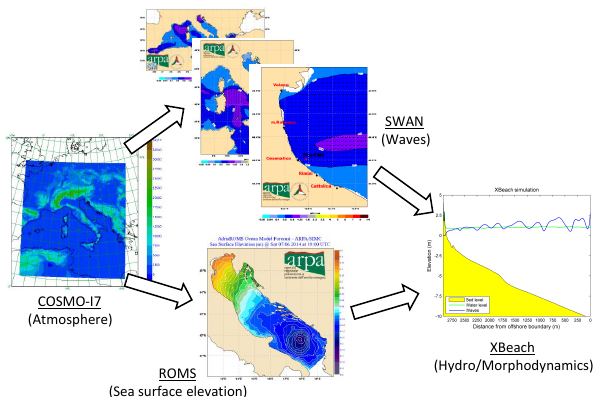
Figure 2. The Emilia-Romagna early-warning system model chain: wind and pressure fields are forecast using the atmospheric model COSMO-I7, which are then used to force the ocean model ROMS and wave model SWAN. Nearshore hydro/morphodynamics are then simulated using XBeach.